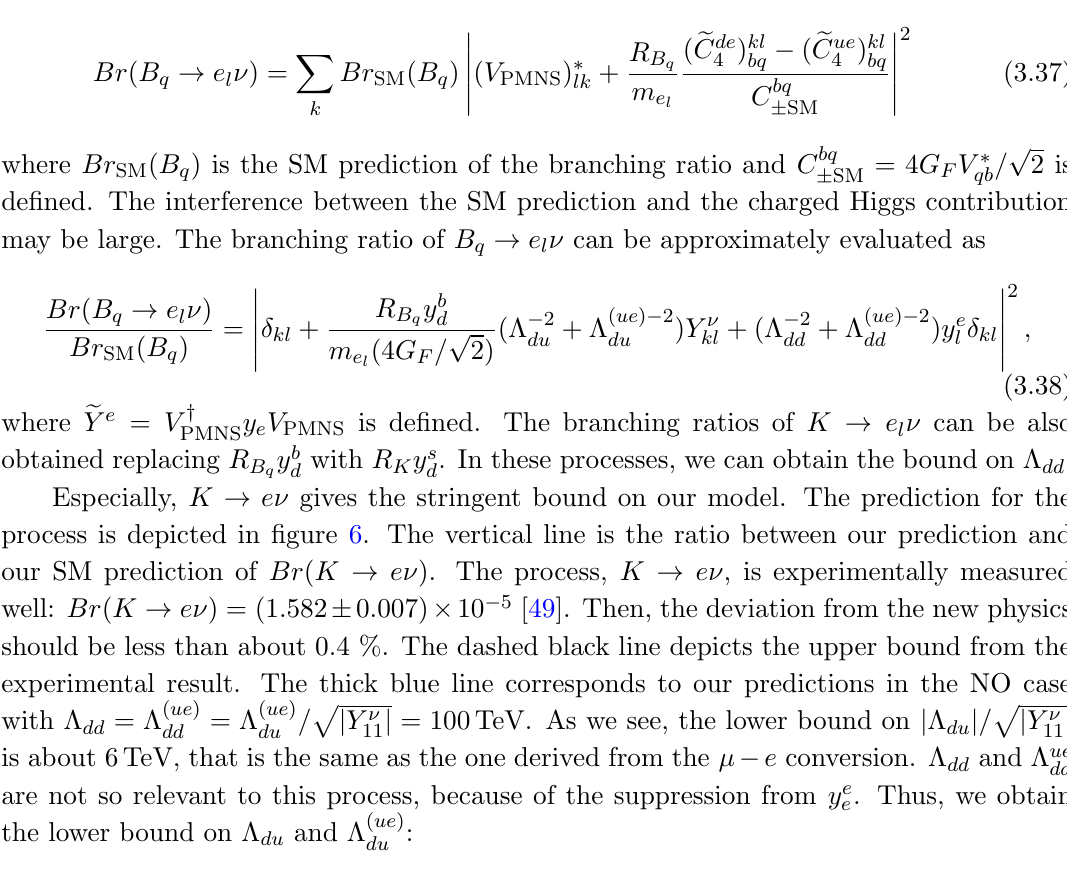
p j Y (cid:23) j . The thick blue line depicts 11 p = (cid:3) ( ue ) = j Y (cid:23) j = 100 11 dd du